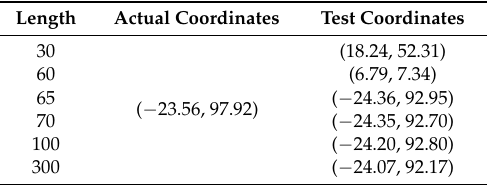
Table 2. Locating result of different lengths.